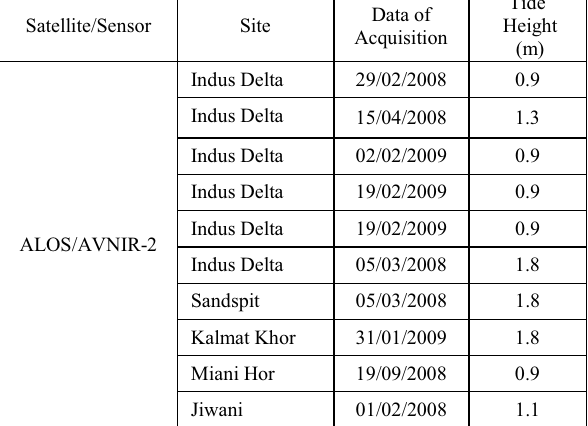
Table 1 : Description of Satellite Data